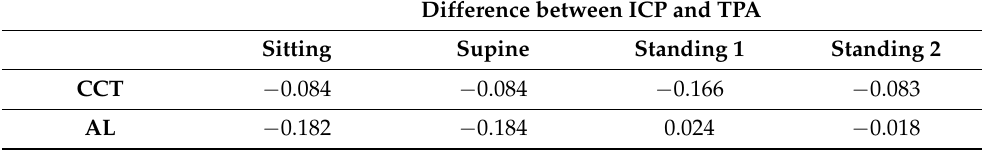
Table 2. Person’s correlation coefficient (r) between difference in intraocular pressure measurements obtained in different positions between Icare PRO (ICP) and Tono-Pen AVIA (TPA), and central corneal thickness (CCT) or axial length (AL). Difference between ICP and TPA Sitting Supine Standing 1 Standing 2